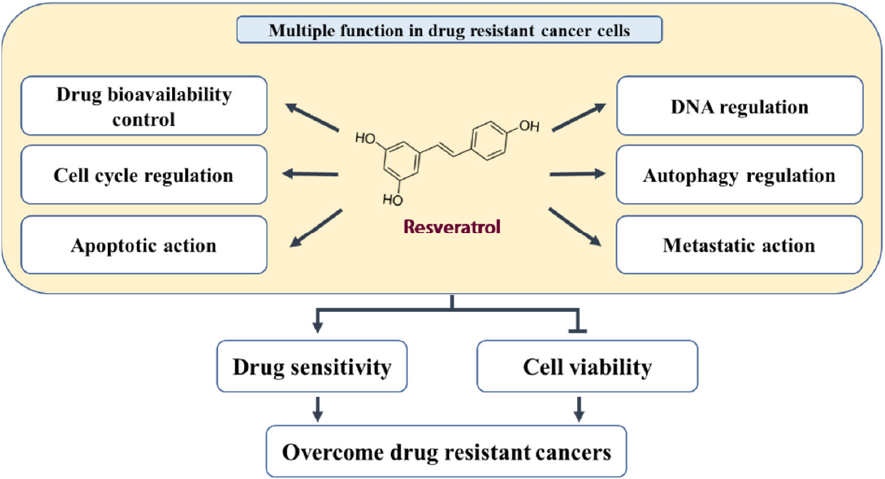
Figure 1. A schematic model of RES function in drug ‐ resistant cancer cells. Table 1. RES ‐ induced regulation of cellular signaling molecules and gene regulatory factors in var ‐ ious drug ‐ resistant cancer cells.